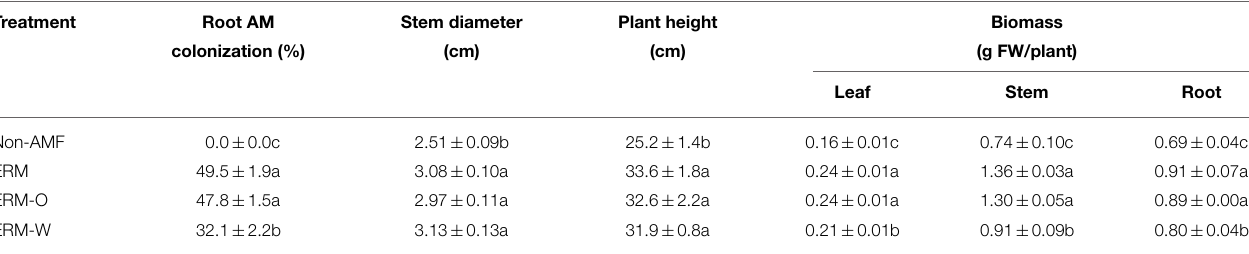
TABLE 1 | Root mycorrhizal colonization and plant growth performance of trifoliate orange inoculated with or without Funneliformis mosseae and grown in 37 µ m nylon-mesh separated root/hyphae compartments.